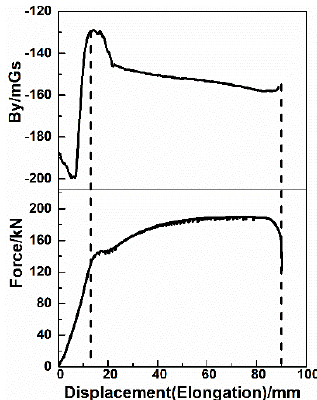
Figure 6. Variation of the By signals, and the tension – displacement curve during static loading of the Φ 20 – C40 – 1